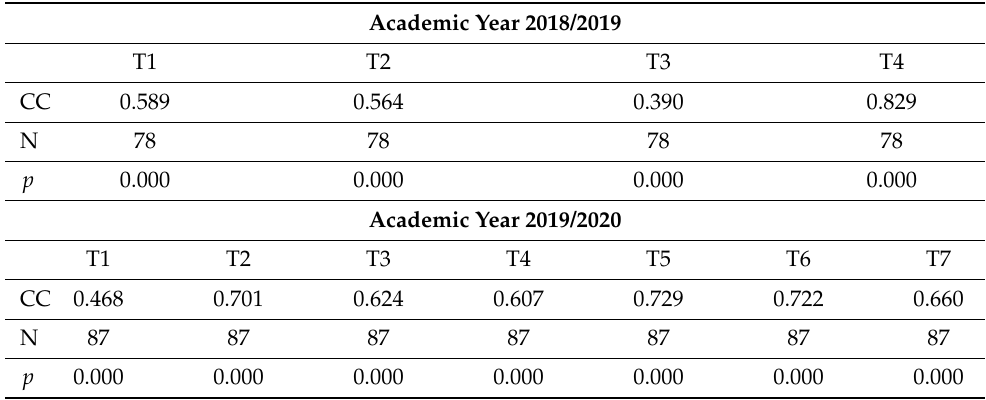
Table 4. Spearman’s Rank Correlation Coefficient Results between Individual and Team Score in RB-G-SIDRA (gamified SIDRA with ranking and badges) and R-G-SIDRA (gamified SIDRA with ranking). “Tx”: Test x; “CC”: Correlation Coefficient; “N”: Sample Size; “ p ”: p